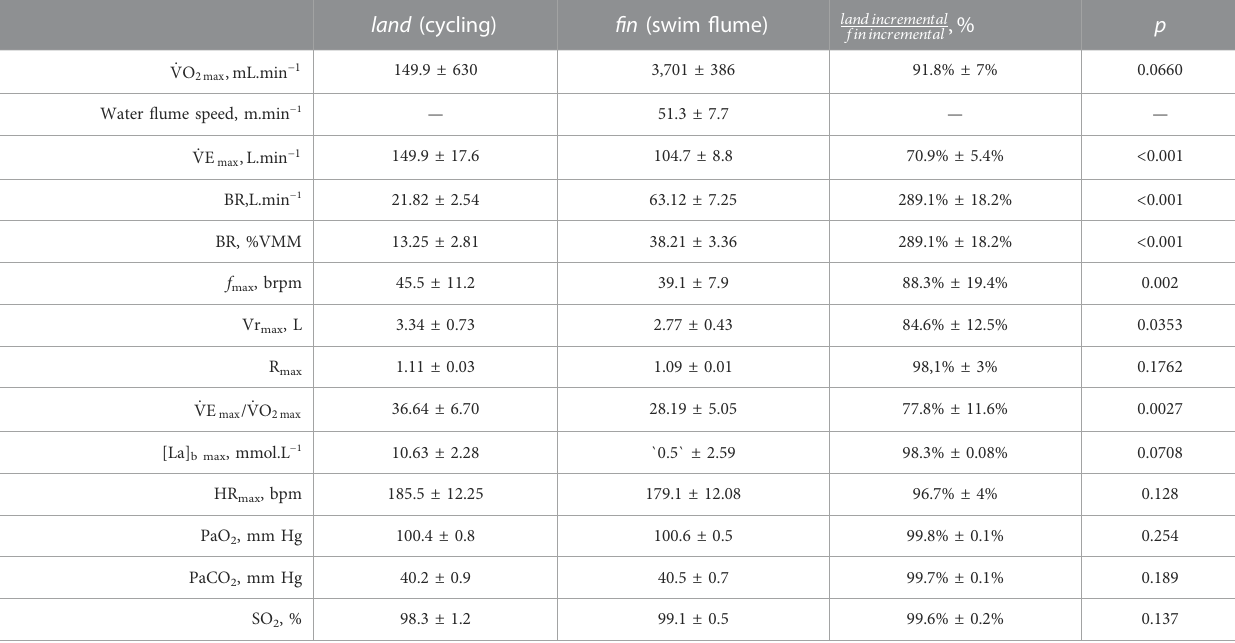
TABLE 2 Maximum physiological responses observed in cycling ( land condition) and fi n swimming ( fi n condition) incremental